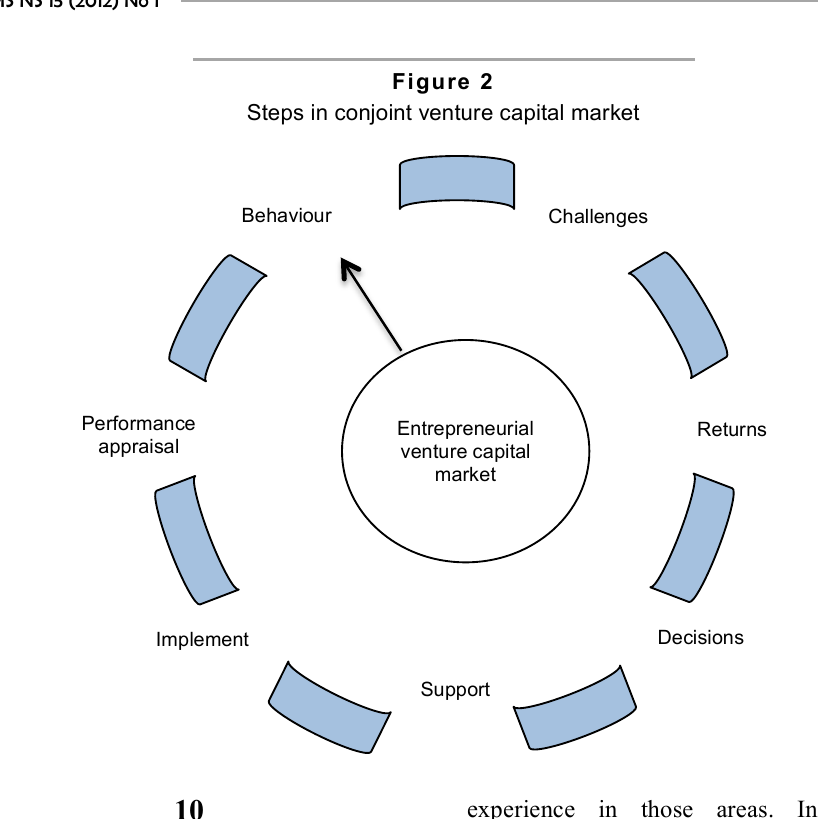
Steps in conjoint venture capital market